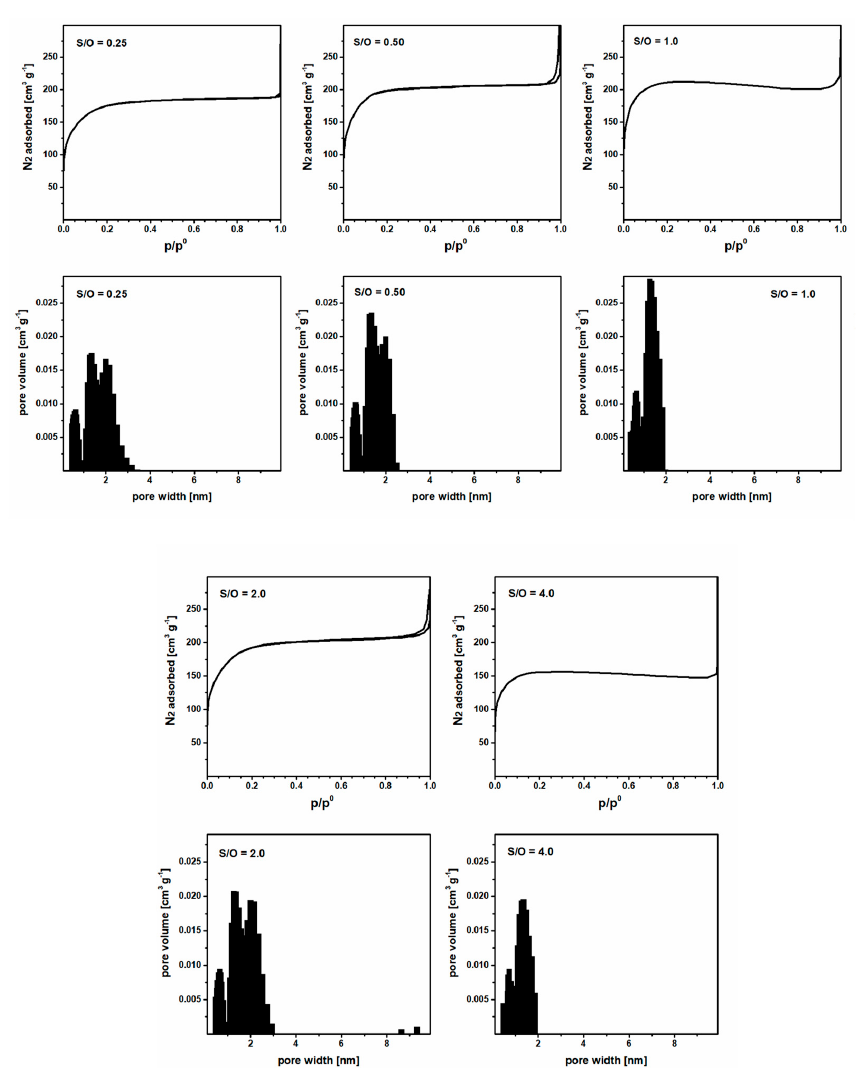
Figure 2. Adsorption isotherms and pore size distributions of the membrane materials (5 mol% Al 2 O 3 –doped silica) synthesized by the sol-gel method with different surfactant/oxide molar ratio (S/O) in the reaction mixture.